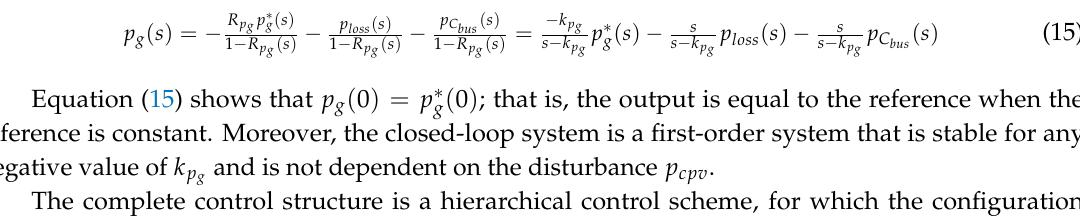
and the ultracapacitors p ∗ uc b